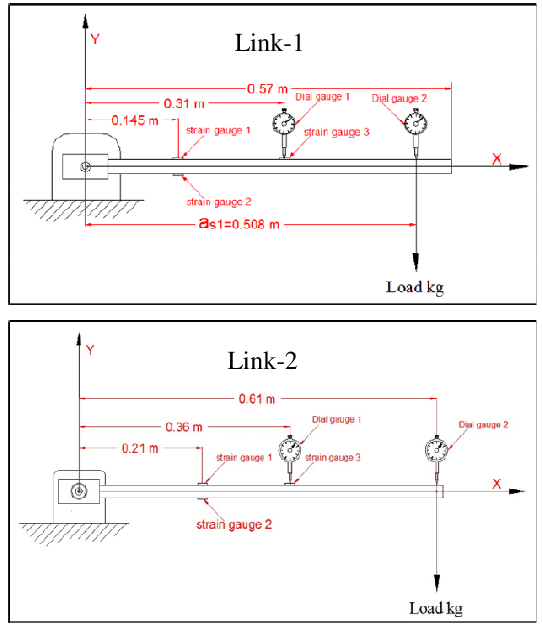
Fig. 5. the distribution of strain gauges and applied load for the two links.